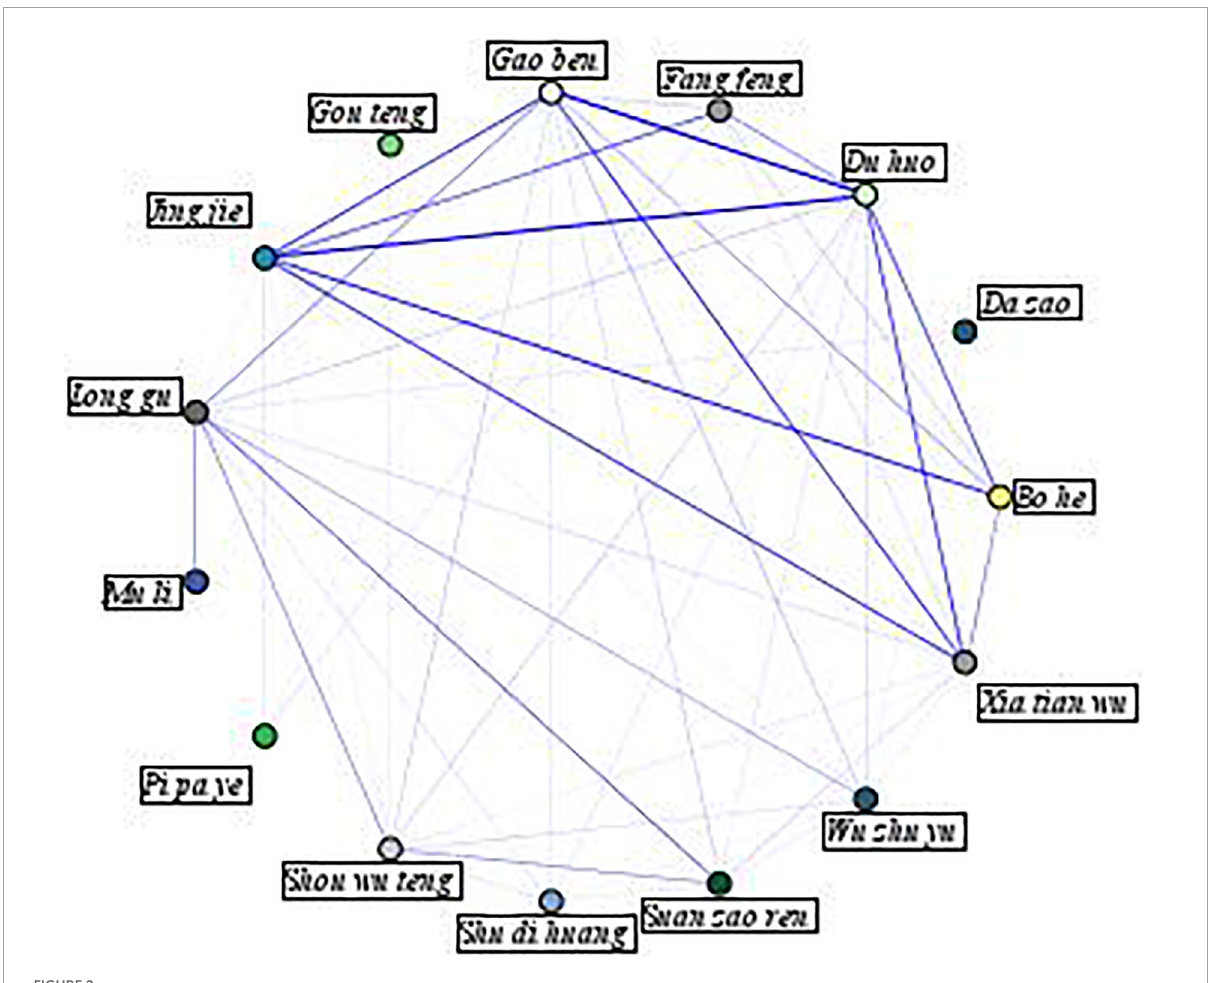
FIGURE2 Network diagram of association rules between